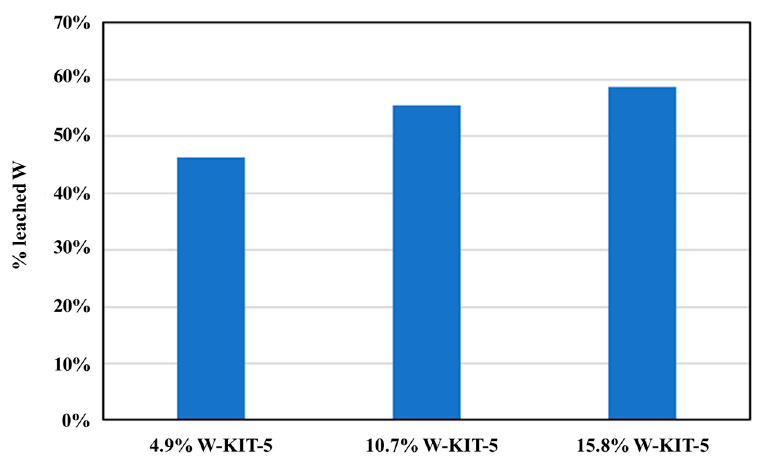
Figure 6. ICP analysis results of the W-KIT-5 catalysts after one